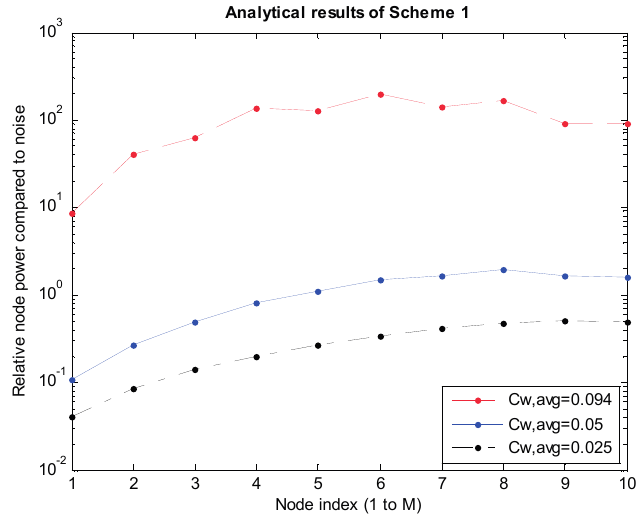
Figure 5. Power levels according to the node in Scheme 1.